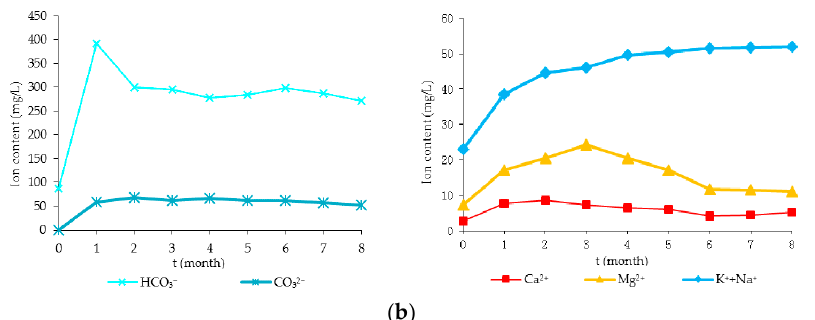
Figure 3. Variations of ion contents with time: ( a ) ML and ( b ) TL.